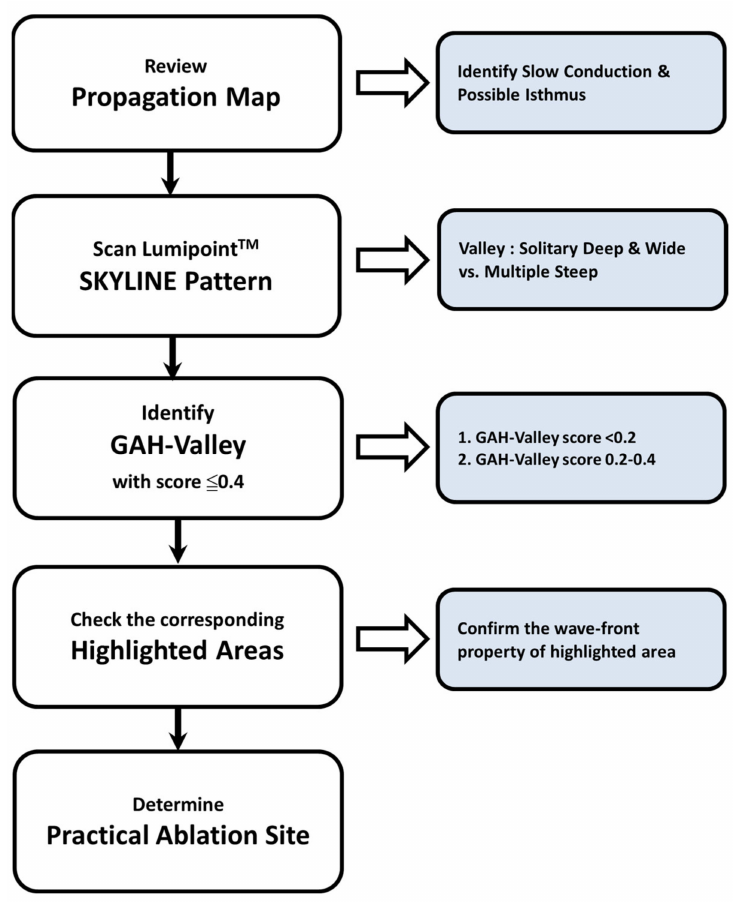
Figure 5. The proposed stepwise approach in Lumipoint TM module to identify practical ablation sites in patients with